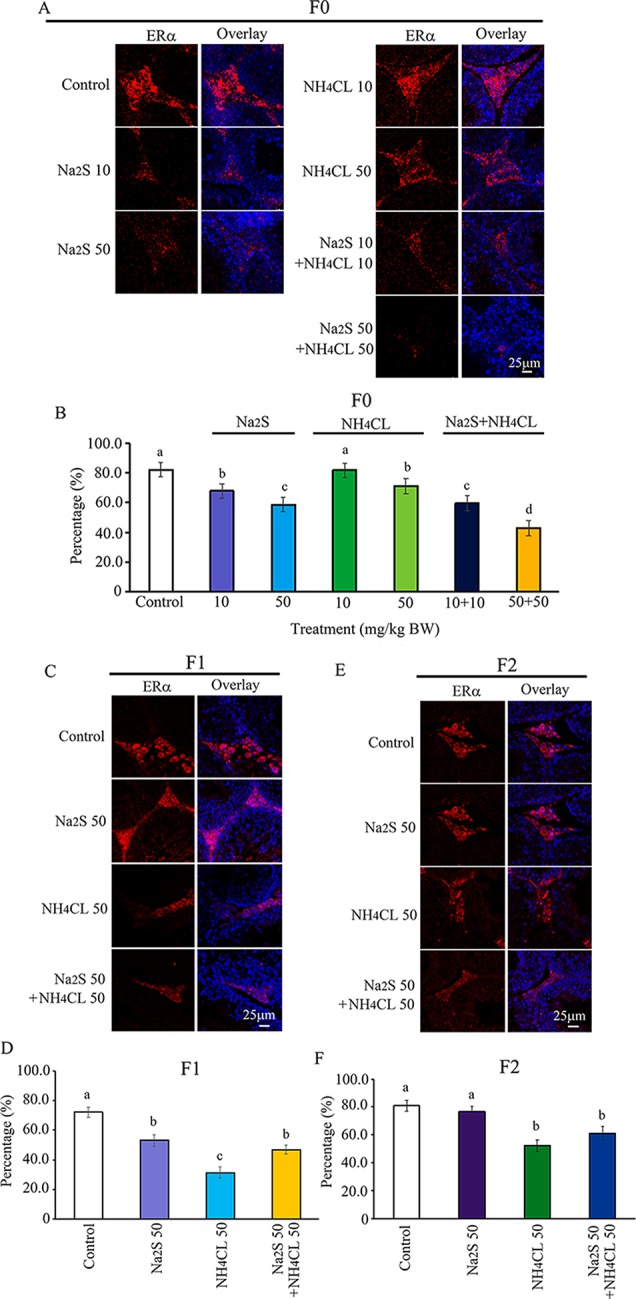
Protein ERα in mouse testicular tissue as detected by immunofluorescence staining. (A) ERα staining in F0 mouse testis. (B) Quantitative data for ERα in F0 mouse testis. (C) ERα staining in F1 mouse testis. (D) Quantitative data for ERα in F1 mouse testis. (E) ERα staining in F2 mouse testis. (F) Quantitative data for ERα in F2 mouse testis. N > 6. a, b, c indicate a significant difference among different treatments (p < 0.05).